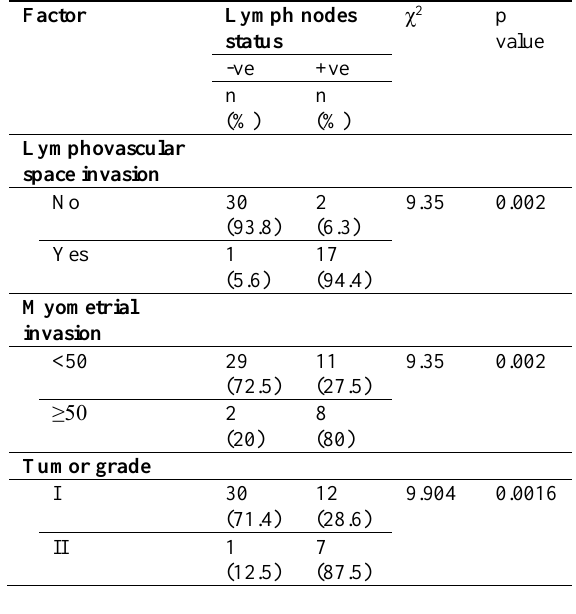
Table 5: Factors determining lymph node status by pathological